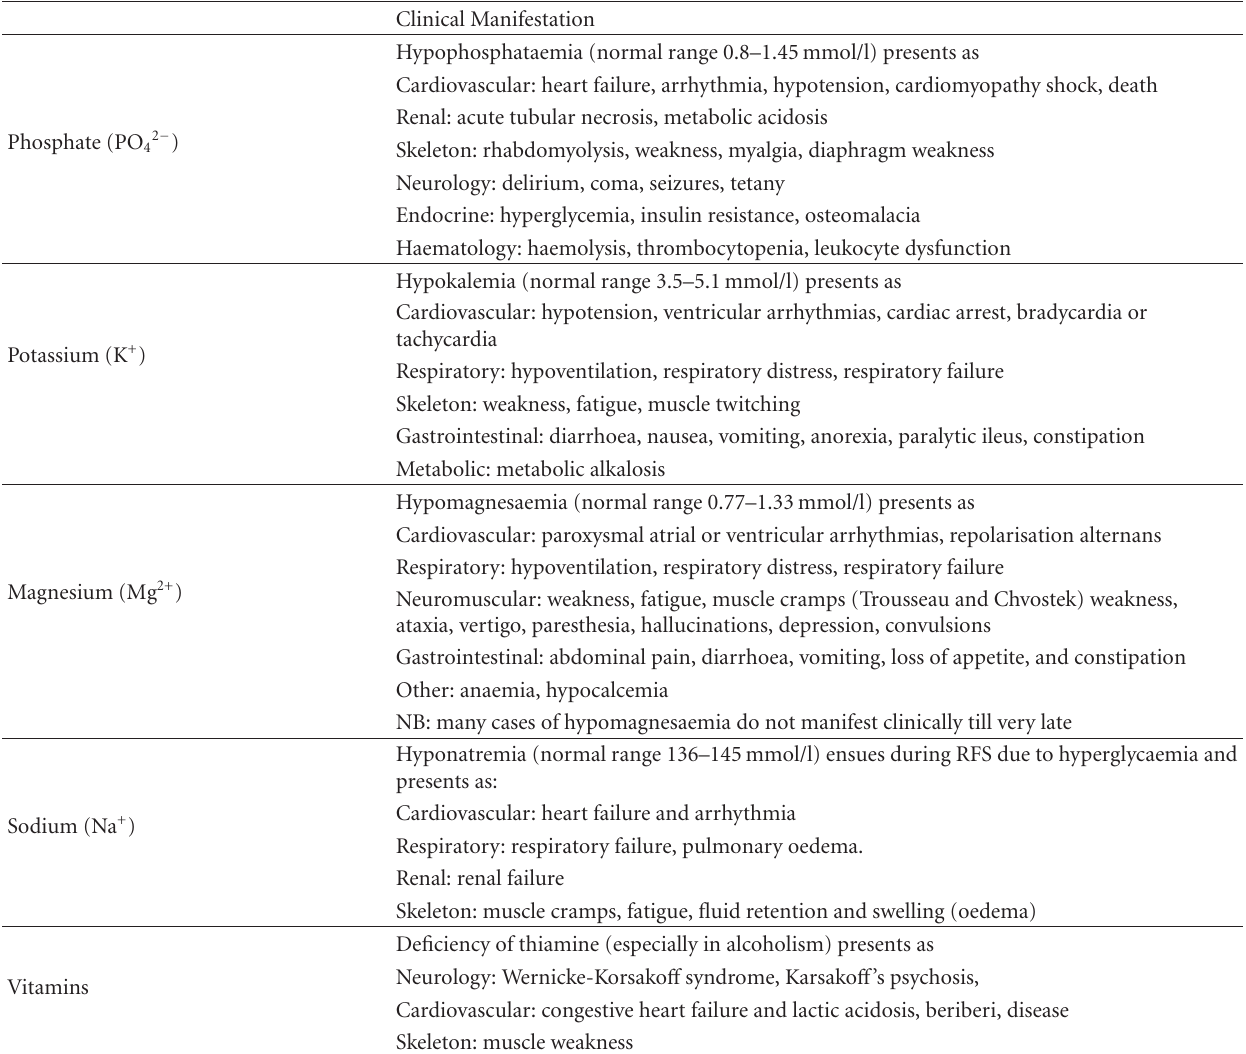
Table 1: Clinical manifestations of electrolyte abnormalities associated with refeeding syndrome [1,